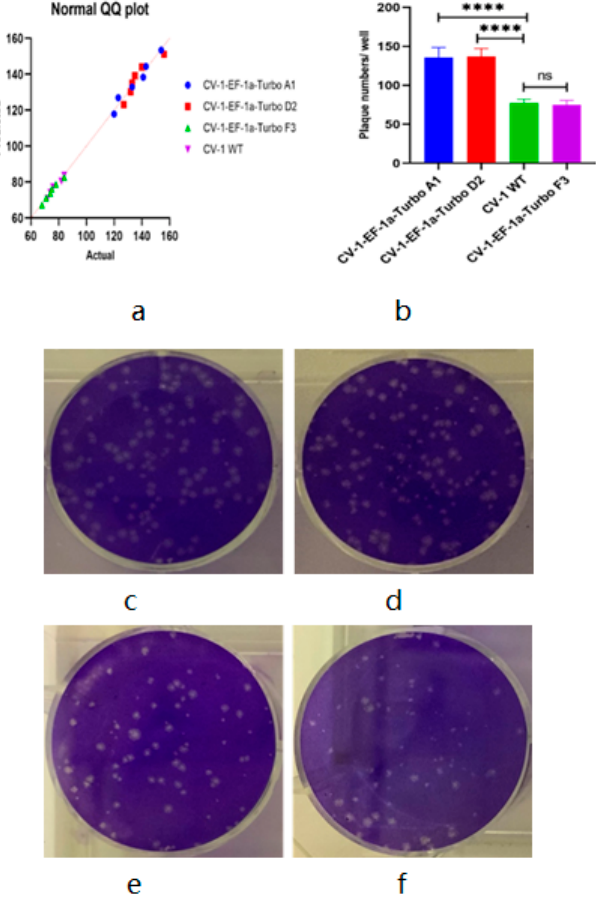
Figure 9. Statistical comparison of viral plaque counting using different CV-1 cell lines as the host. ( a ) Q–Q plot of plaque counts using different CV-1 cell lines. ( b ) Statistical comparison of plaque counts using different CV-1 cell lines through crystal violet staining method (n = 6). ns: not significant, p = 0.4509; **** p < 0.0001 (two-way ANOVA 6 SEM). Crystal violet stain of different Lister